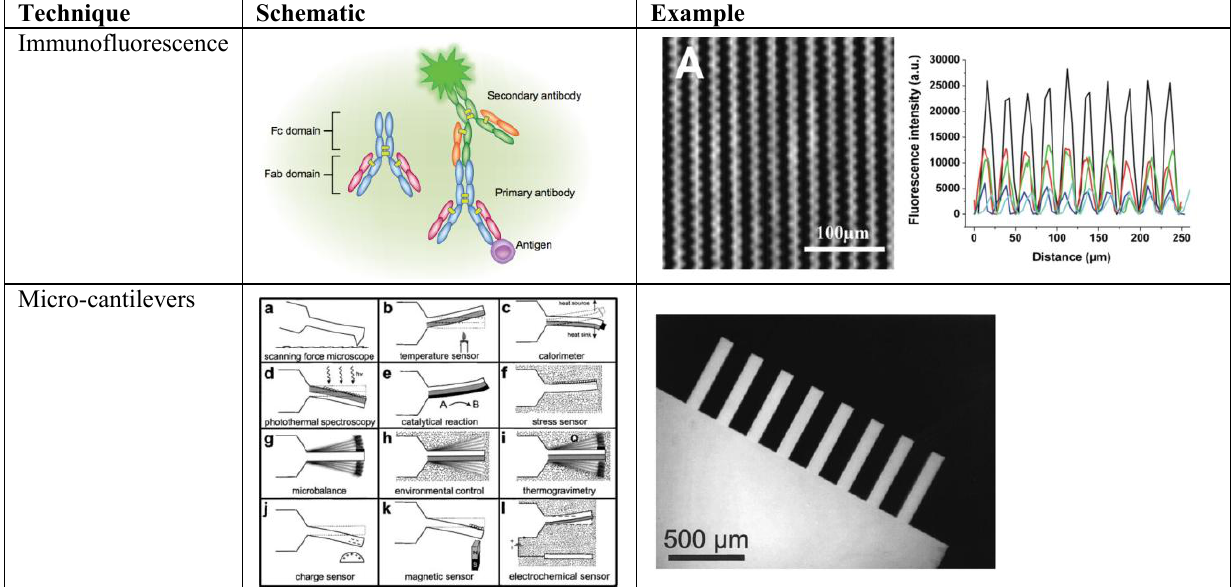
Figure 1. Select biosensor transducer schematics and examples of use.